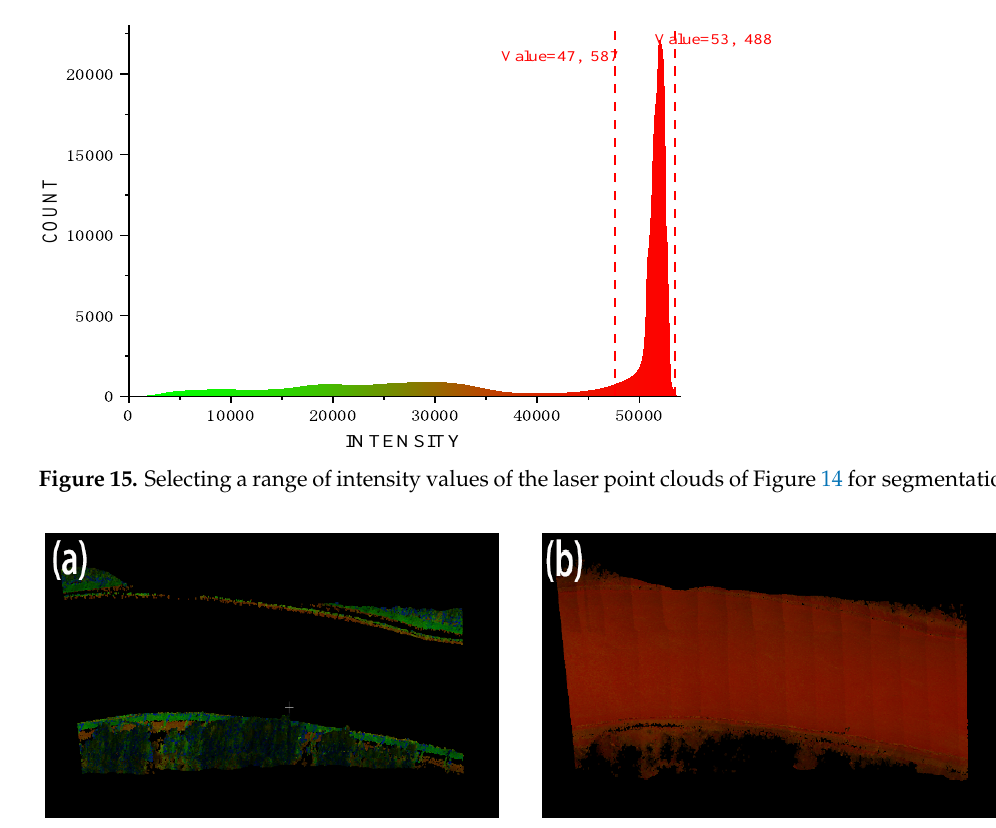
Figure 16. The point clouds of the Figure 14 is segmented according to the intensity: ( a ) is the non-ground points; ( b ) is the ground points.